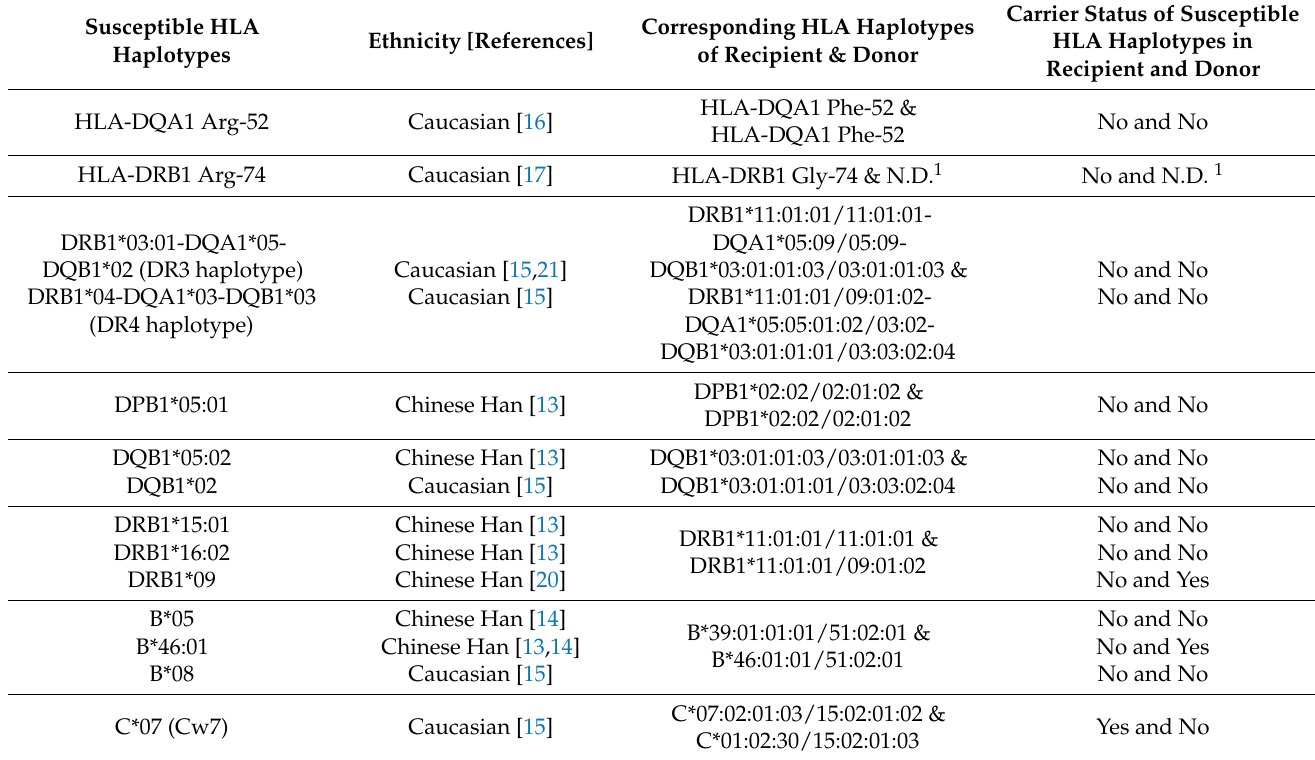
Table 1. HLA haplotypes of the patient and donor (his father) compared to those reportedly suscepti- ble to Graves’